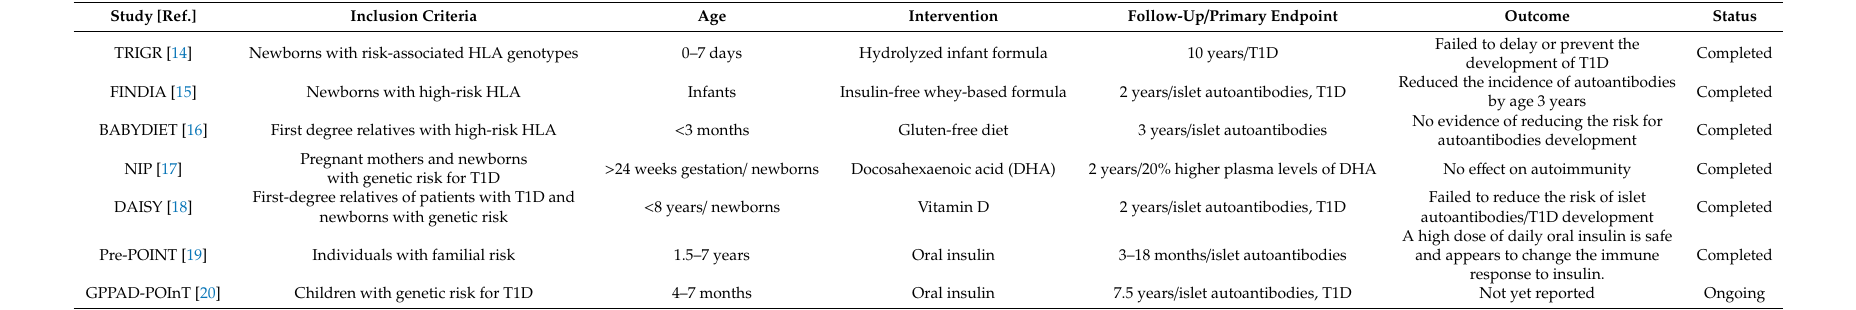
Table 2. Primary prevention trials before clinical diagnosis of